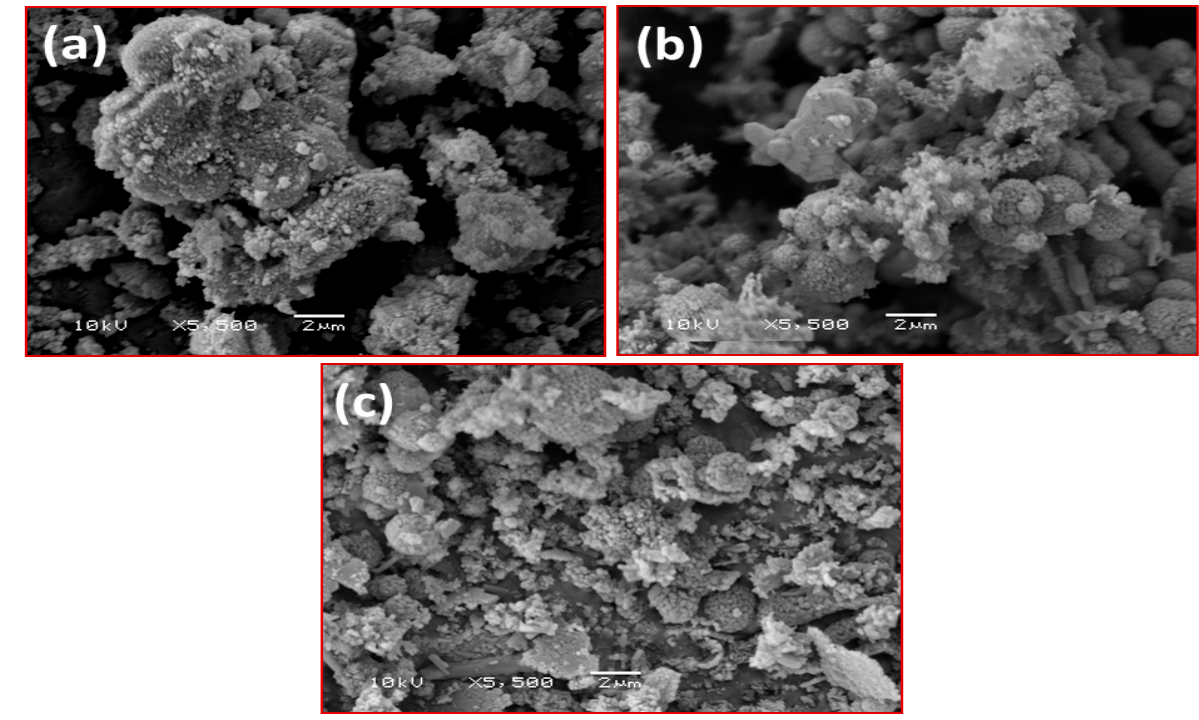
Figure 3. FESEM images of BT1 samples: ( a ) as-prepared, ( b ) calcined at 600 °C, ( c ) calcined at 900 °C. Scale bar in ( a ), ( b ) and ( c ) is 2 µm.